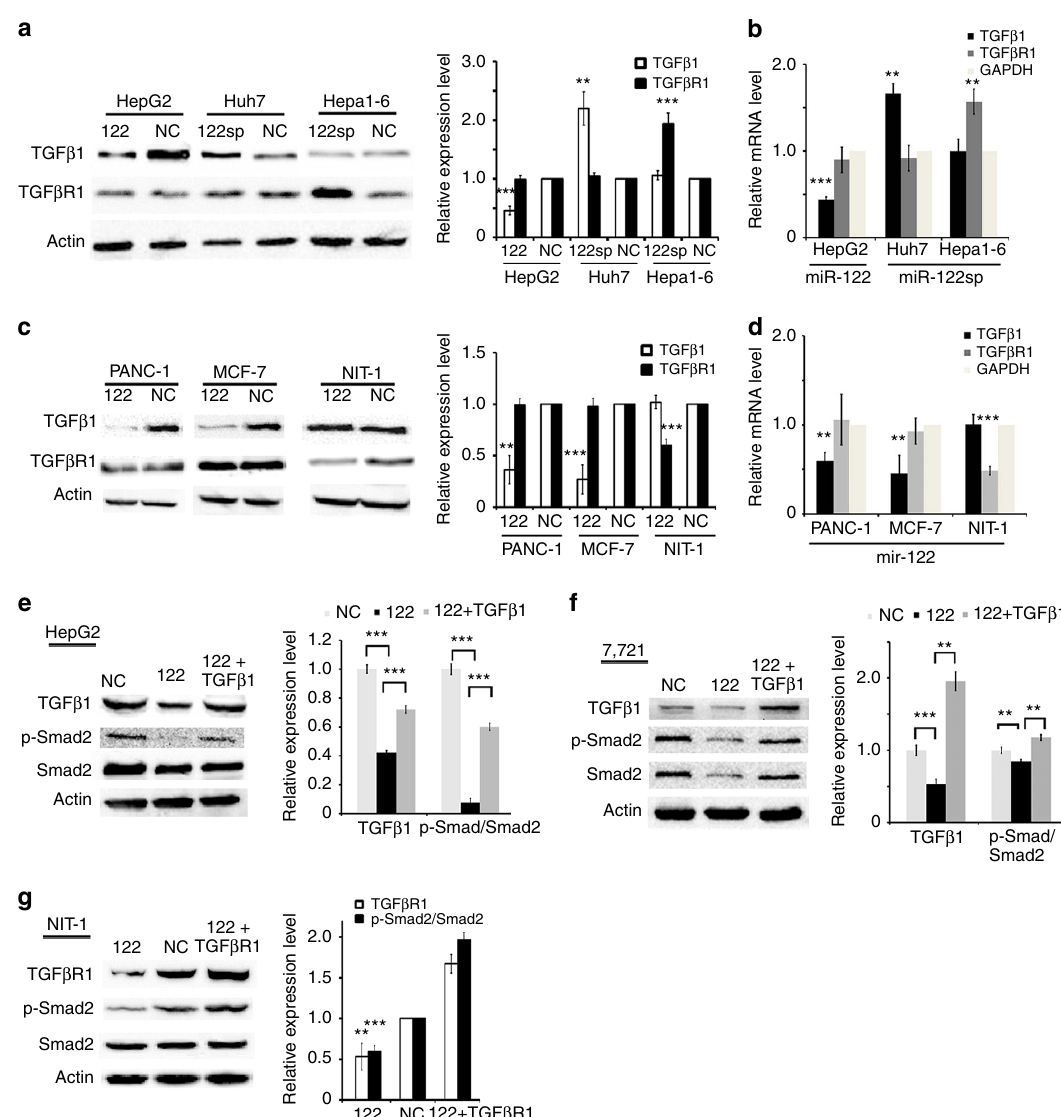
Figure 1 | miR-122 inhibits TGF b 1 in human cells, but TGF b R1 in mouse cells. ( a ) Western blot analysis of TGF b 1 and TGF b R1 in HepG2, Huh7 or Hepa1-6 cells when treated with an miR-122 expression plasmid (122), miR-122 sponge (122sp) or scramble sequence as an negative control (NC), respectively. Quantitative analysis is shown on the right, and three independent repeats are performed in each experiment. HepG2 and Huh7 are human liver cancer cells, while Hepa1-6 is mouse cell line. ( b ) Real-time PCR analysis of TGF b 1 and TGF b R1 mRNAs in either HepG2, Huh7 or Hepa1-6 cells treated with miR- 122, miR-122sp or NC. Three independent repeats are performed in each experiment. ( c ) Western blot analysis of TGF b 1 and TGF b R1 in PANC-1 or MCF-7 cells as well as NIT-1 cells transfected with a miR-122 expression plasmid or NC, respectively. Quantitative analysis is shown on the right. n ¼ 3. PANC-1 or MCF-7 are human non-liver cell line, while NIT-1 is a mouse pancreatic b -cell line. ( d ) Real-time PCR analysis of TGF b 1 and TGF b R1 mRNAs in PANC-1 or MCF-7 cells as well as NIT-1 cells treated with miR-122 or NC. Three independent repeats are performed in each experiment. ( e ) Western blot analysis of intracellular TGF b 1, Smad2 and p-Smad2 in HepG2 cells transfected with miR-122, NC or miR-122 together with TGF b 1, respectively. Quantitative analysis is shown on the right. Three independent repeats are performed in each experiment. ( f ) Western blot analysis of intracellular TGF b 1, Smad2 and p-Smad2 in SMC-7721 cells transfected with miR-122, NC or miR-122 together with TGF b 1. Quantitative analysis is shown on the right, and three independent repeats are performed in each experiment. ( g ) Western blot analysis of intracellular TGF b R1, Smad2 and p-Smad2 in NIT-1 cells transfected with miR-122, NC or miR-122 together with TGF b R1. Quantitative analysis is shown on the right, and three independent repeats are performed in each experiment. Error bars, ± s.d. ** P o 0.01; *** P o 0.001 by two-sided Student’s t -test. b -Actin was used as a loading